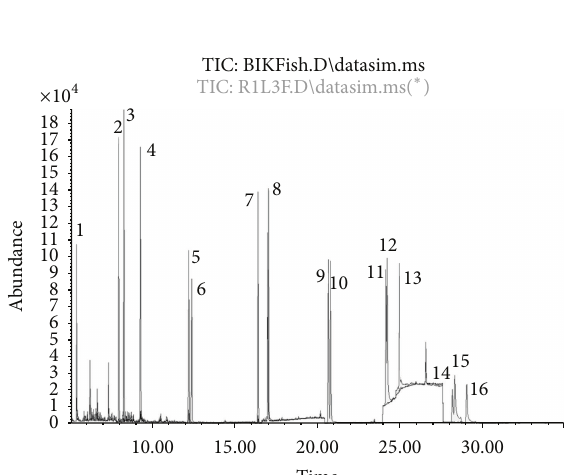
Figure 1: Representing total ion chromatogram of 16 PAHs in fish sample at level 50 𝜇 g/kg by